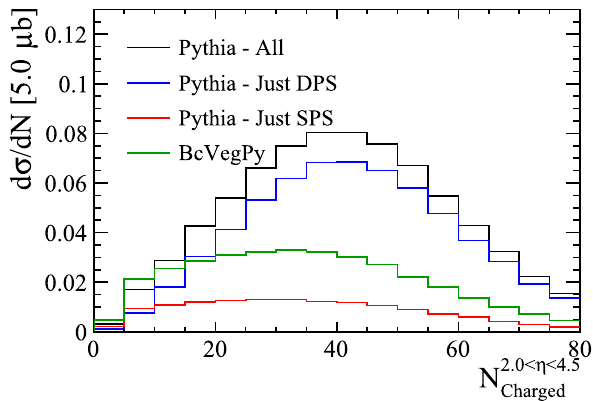
Fig. 11 Distribution of the number of charged particles within 2 . 0 < η < 4 . 5 in events containing a B + and Pythia